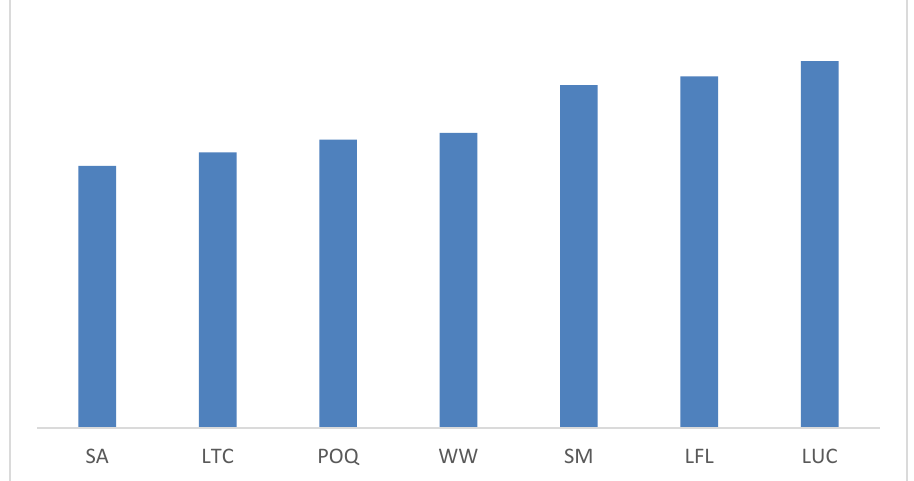
Fig. 2. The amount of costs between different methods